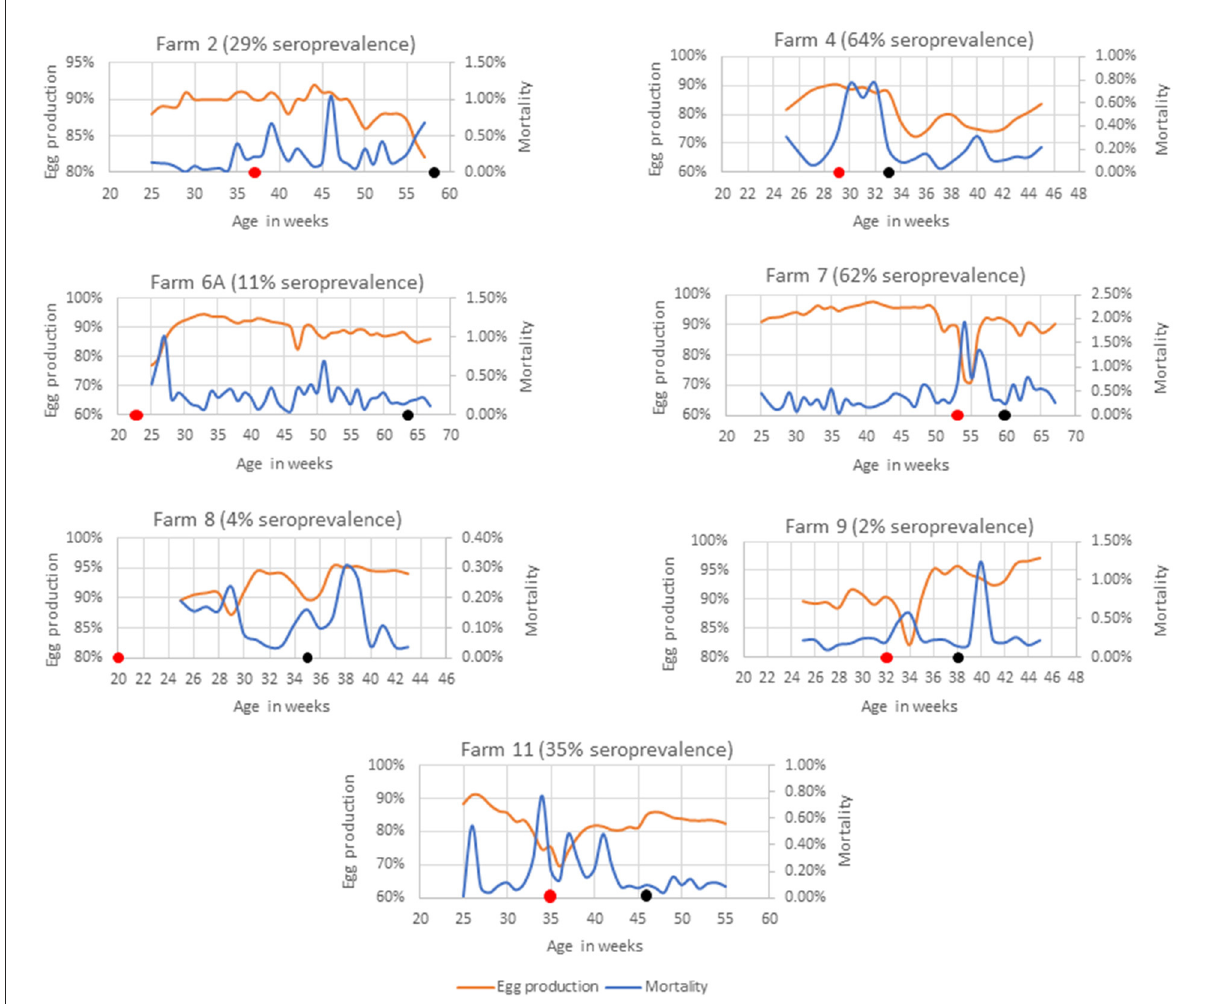
FIGURE2 Mortality and egg production in farms with a known history of SLD outbreak. The black dot indicates the week of sample collection and the red dot indicates the week in which, the first SLD associated death was